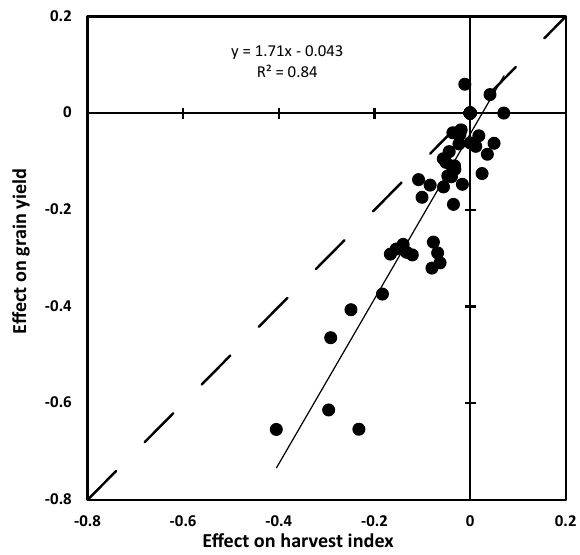
Figure 2. Relative effects of ozone on grain yield vs. harvest index based on 19 experiments with field-grown wheat from 8 countries. Effects are relative to the treatment with charcoal-filtered air, i.e. an ozone concentration near zero. The broken line represents a hypo- thetical 1 : 1 relationship.